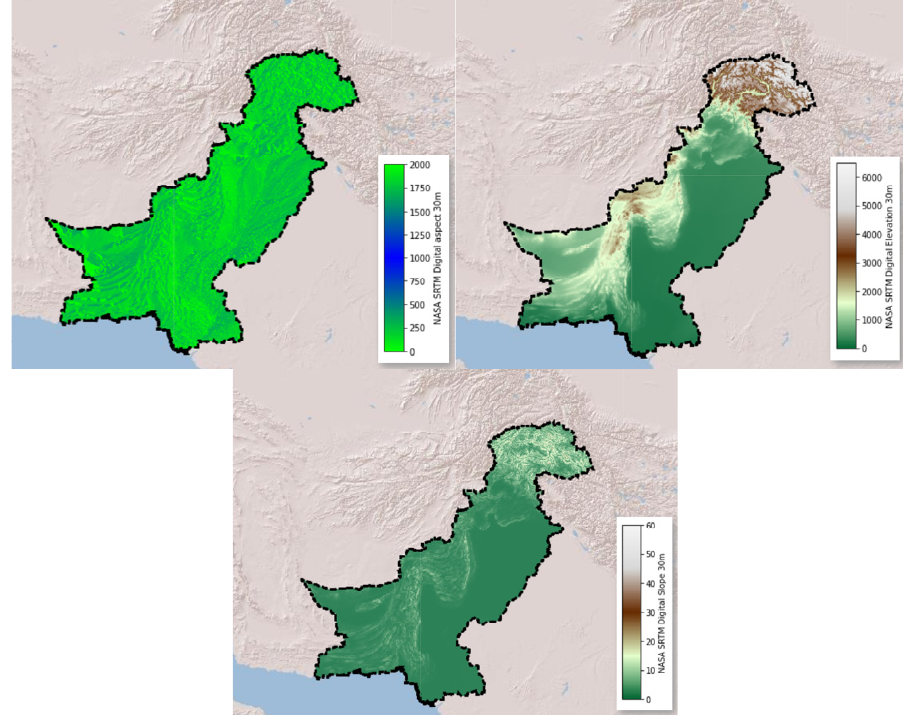
Figure 6. Topographical factors: aspect, elevation, and slope.